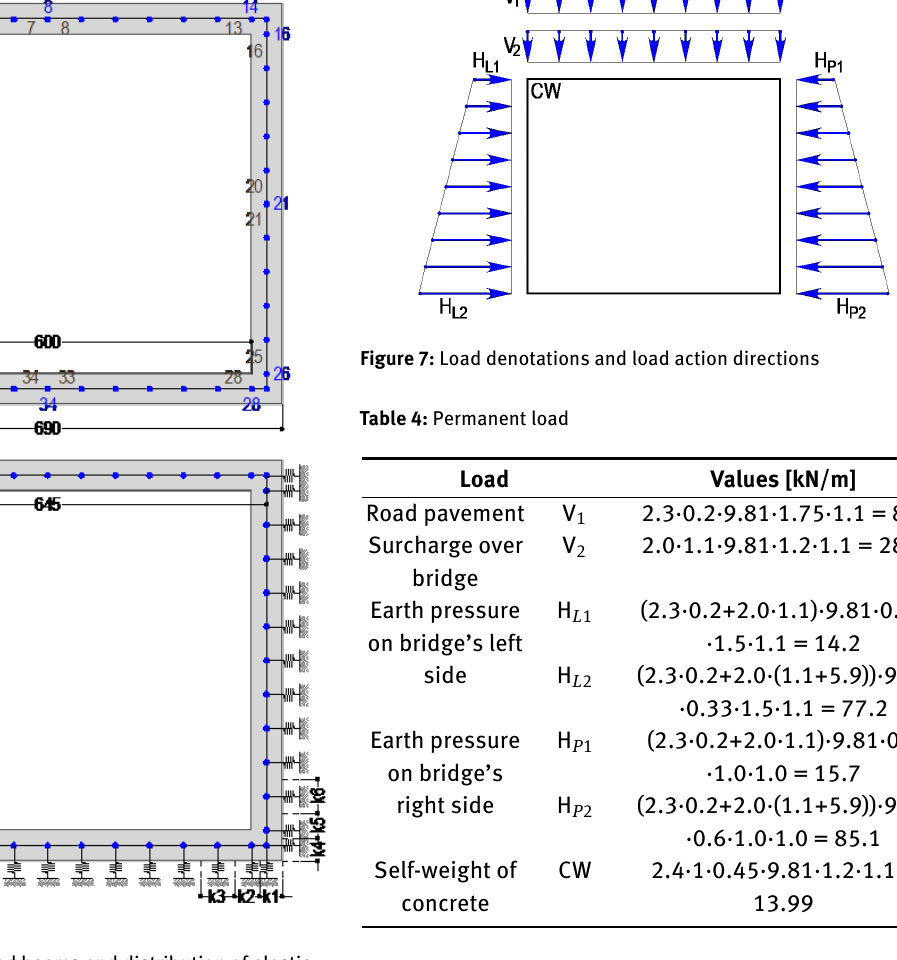
Table 5: Concrete elastic moduli and Poisson’s ratios